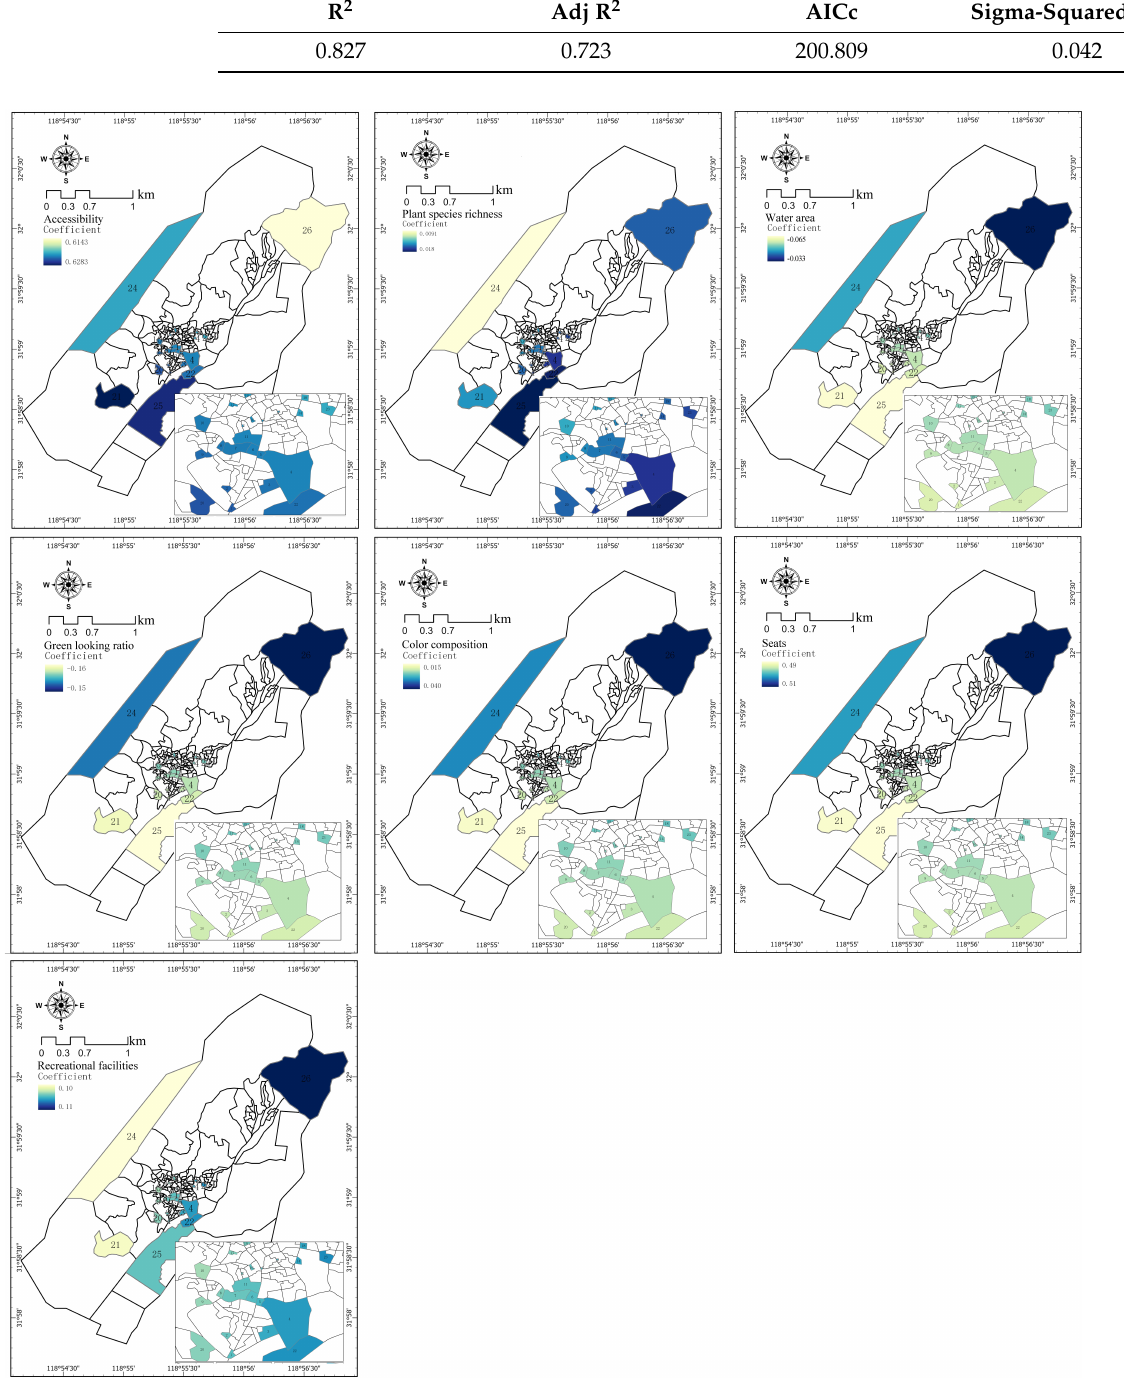
Figure 6. . Figure 6. Spatial Patterns of Regression Coefficients between Tourist Vitality and the Factors of